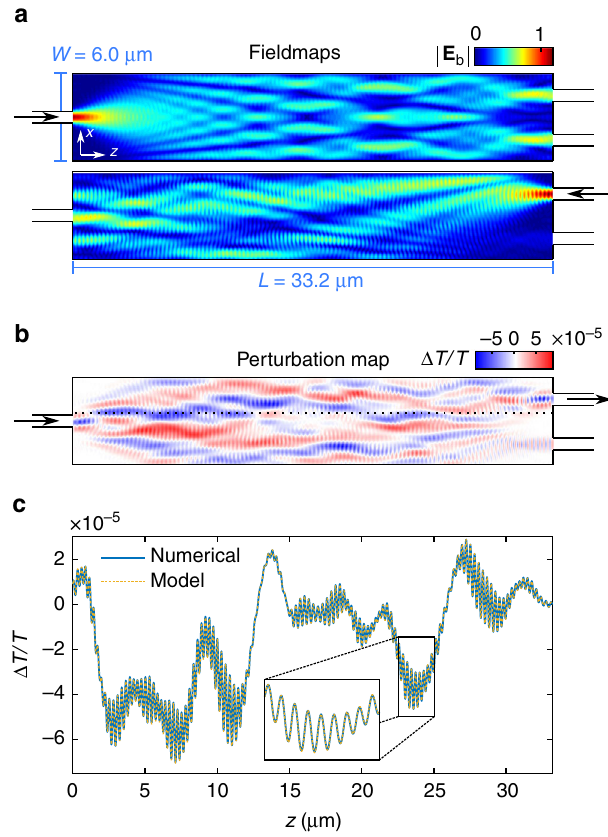
Fig. 2 Validity of the reciprocity-based model for sub-wavelength perturbations. The photonic structure is a 1 × 2 MMI device of length L = 33.2 μ m and width W = 6.0 μ m operating at 1.55 μ m (see Methods for more details). a Norms of the background electric fi eld generated by ingoing excitations from the fundamental modes of the input and upper (cid:2) (cid:2) (cid:2) (cid:2) (cid:2) (cid:2) , respectively. b Resulting perturbation output waveguides, E þ b ; m map as predicted using Eq. (8) for a cylindrical perturbation of diameter 2 R = 10 nm and refractive index variation Δ n = − 0.25. c Comparison between the perturbation curves for the same system along a cut (black dotted line in b ) obtained from a-FMM performed for each perturbation position (fully- numerical, blue solid line), and predicted from the reciprocity-based